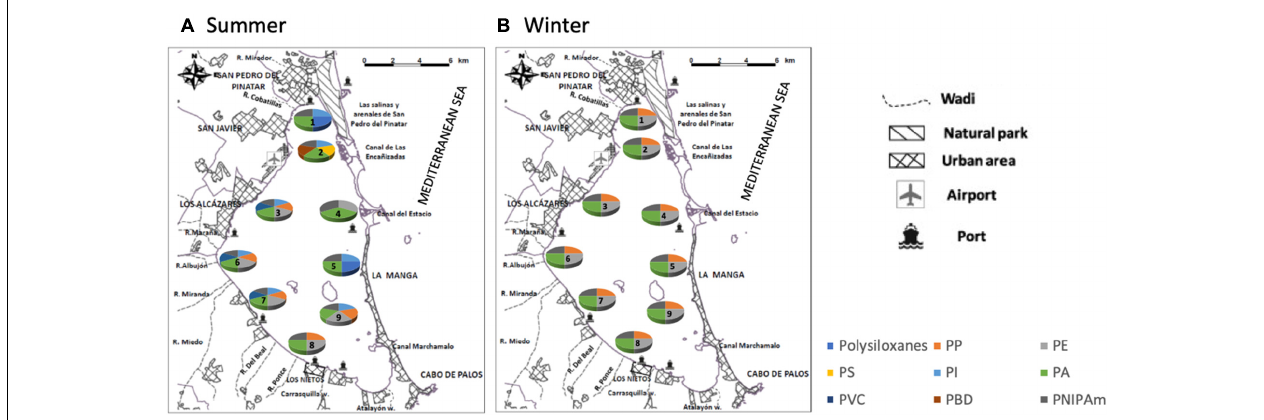
FIGURE 1 | Occurrence of polymer micro(nano)plastics in Mar Menor during the 1st ( A , Summer) and the 2nd ( B , Winter) sampling periods of this study.